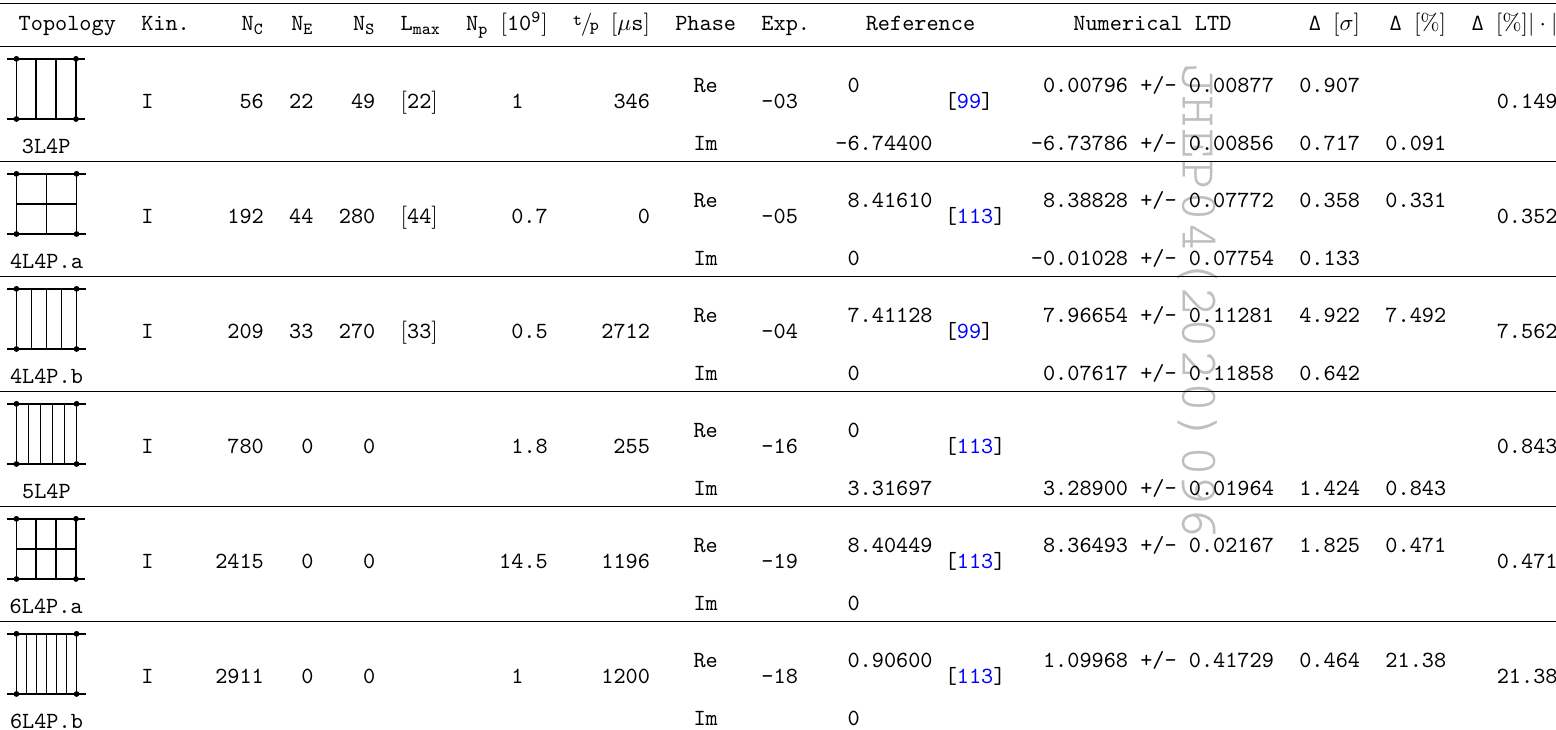
Table 3. Results for three- to six-loop ladder and (cid:12)shnet integrals. The (cid:12)ve- and six-loop con(cid:12)gurations do not have any singular E-surfaces. See the main text for